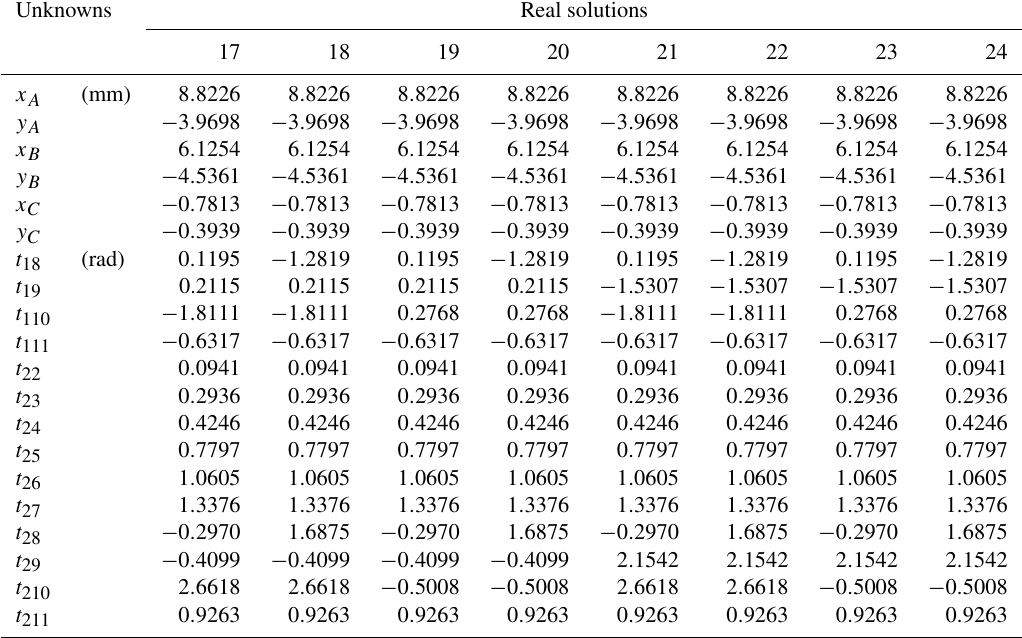
Table A8. Real solutions